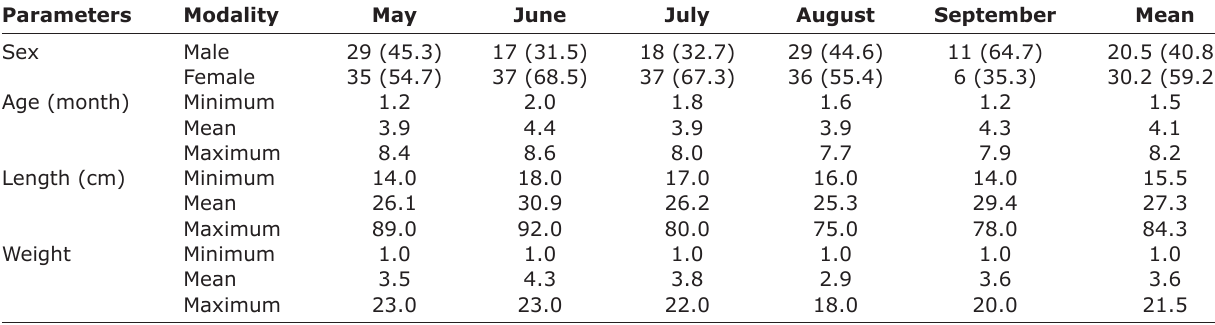
Values in bracket represent fetal wastage proportion (%) Table-2: Characteristics of fetuses wasted at ELAKAT provincial slaughterhouse. Parameters